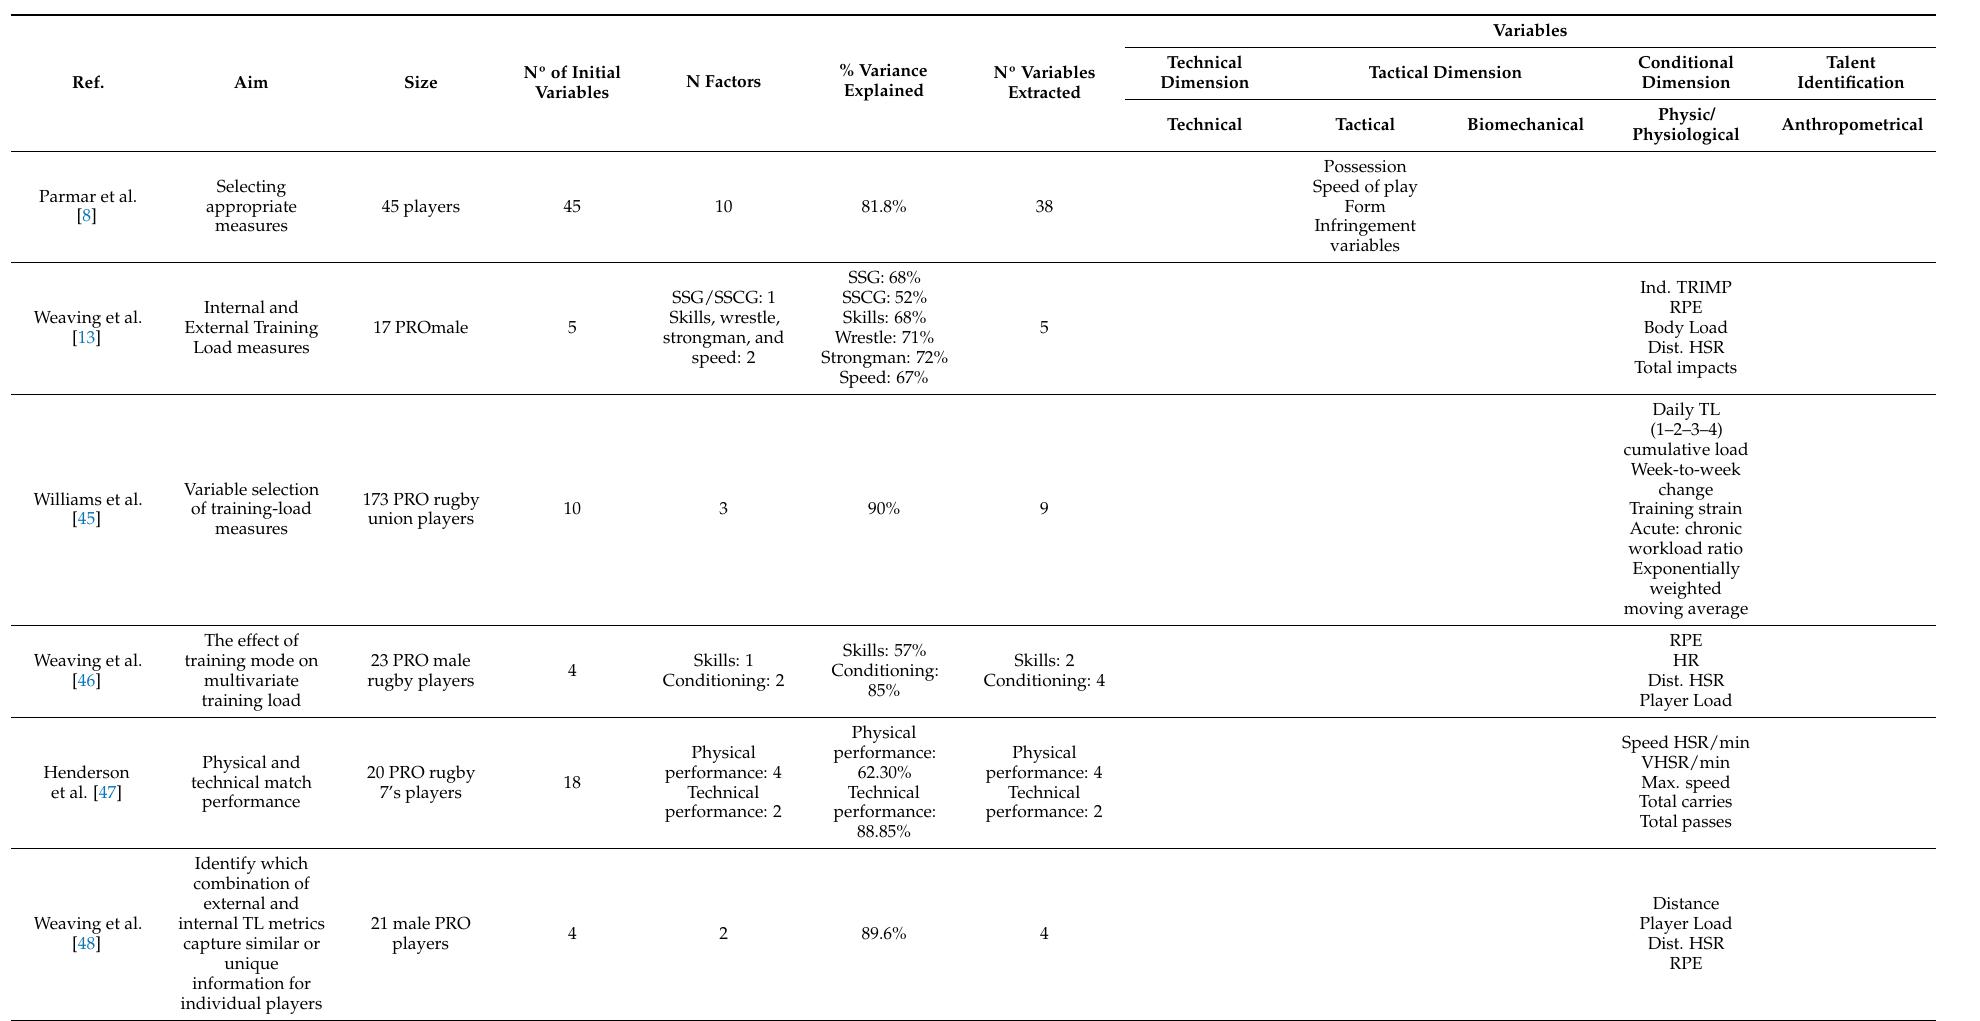
Table 3. Variables extracted through PCA in